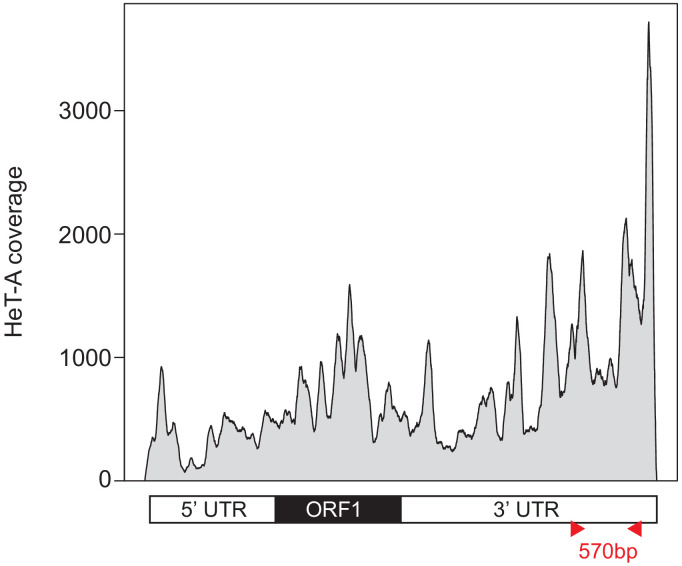
Strategy for HeT-A FISH probe design.Genome coverage plotted along the HeT-A consensus sequence from the pool-seq data. The HeT-A probe corresponds to the most abundant region. Probe primers (Supplementary file 4) are depicted with red arrowheads.